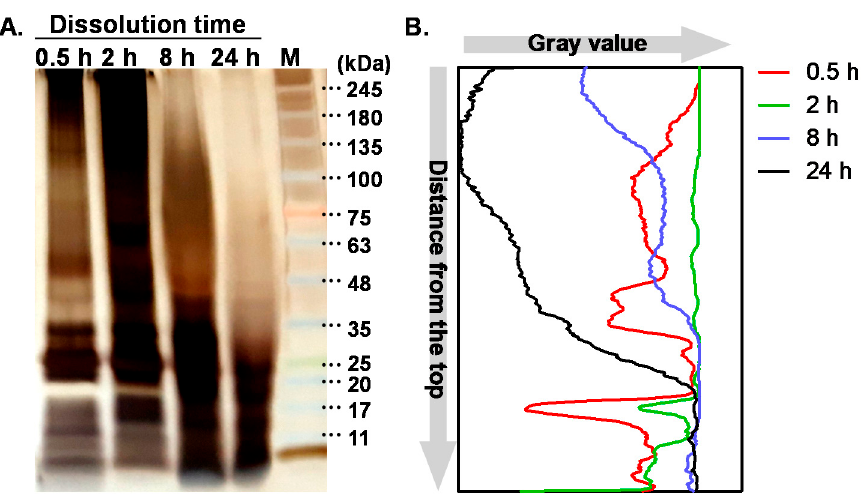
Figure 1. SDS-PAGE results of four silk fibroin (SF) solutions. ( A ) Silver-stained gel image showing the difference of SFs in molecular weight distribution. The lane on the right side indicates the molecular weight marker. The other four lanes represent SF with increasing dissolution time, from left to right. ( B ) The gray value profiles of protein bands on the SDS-PAGE gel. The set of intensity values is taken from each lane, from the top to the bottom, and plotted in the